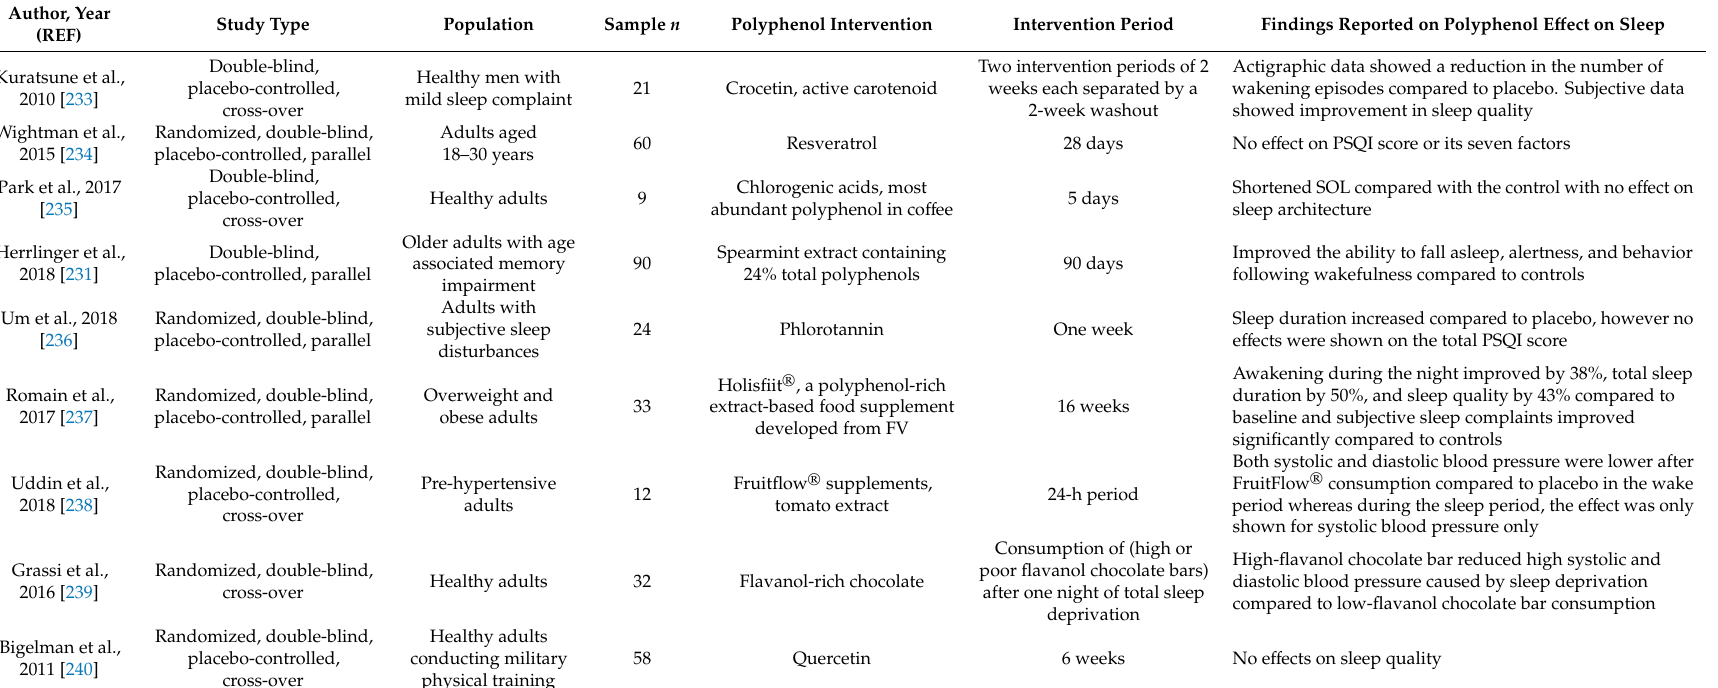
Table 4. Adult human interventional studies exploring the e ff ects of polyphenols on